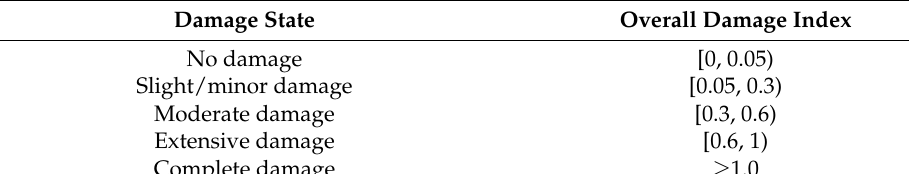
Table 9. Damage criteria for models built in the IDARC-2D program.